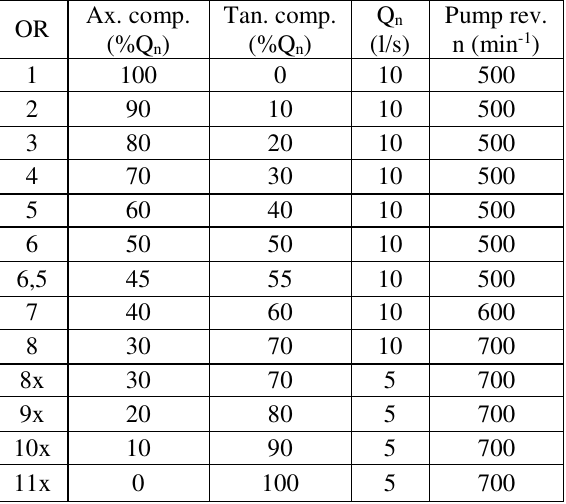
Tab. 3. Operating regime of longitudinal